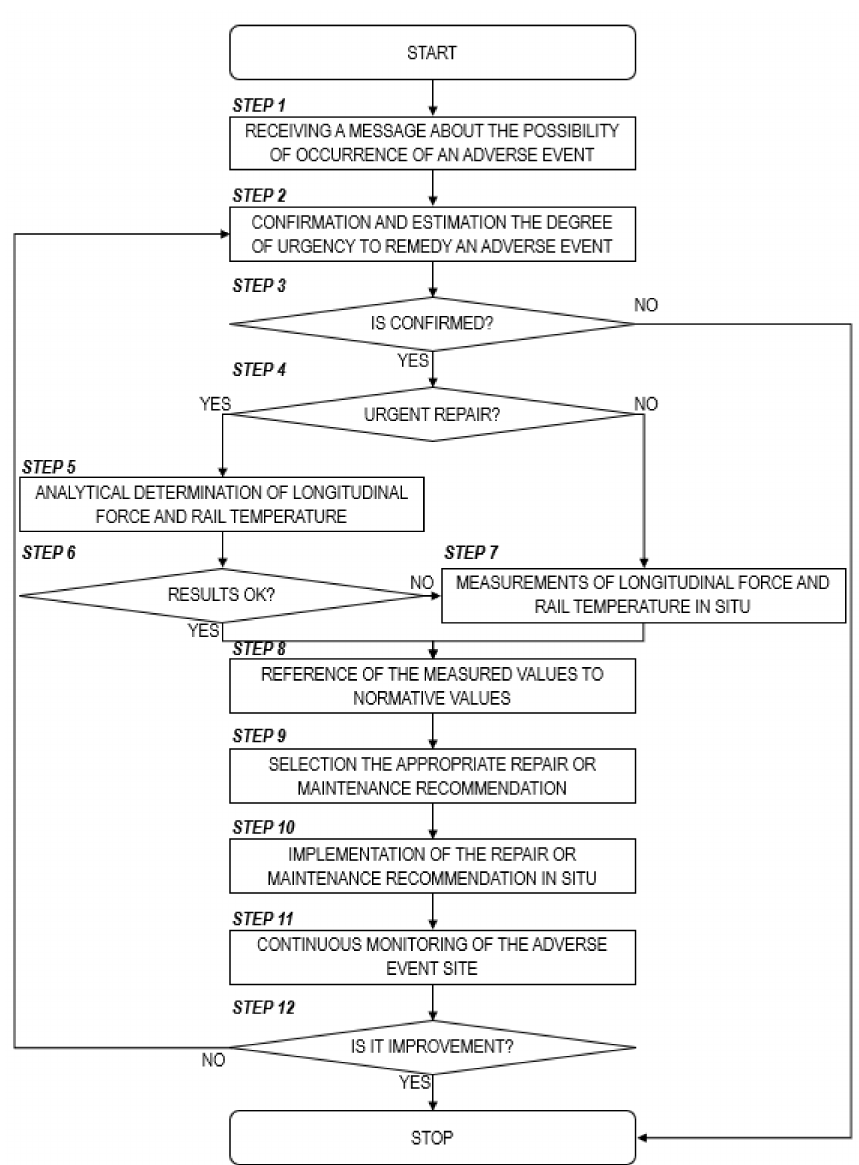
Figure 3. Scheme of the continuous welded track condition diagnosis method based on experimental tests (measurements) (source: own